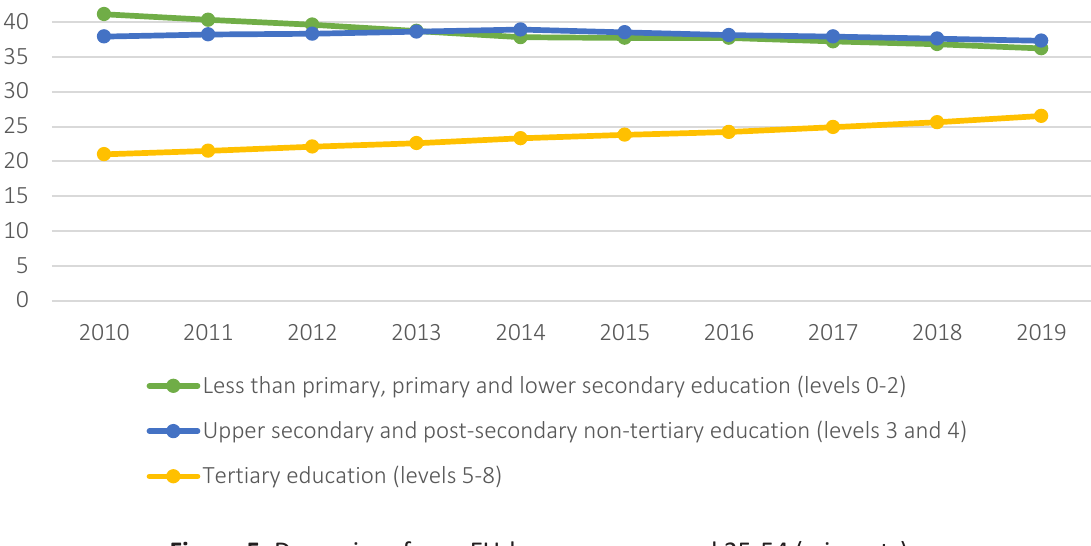
Figure 5. Dynamics of non-EU-born persons aged 25-54